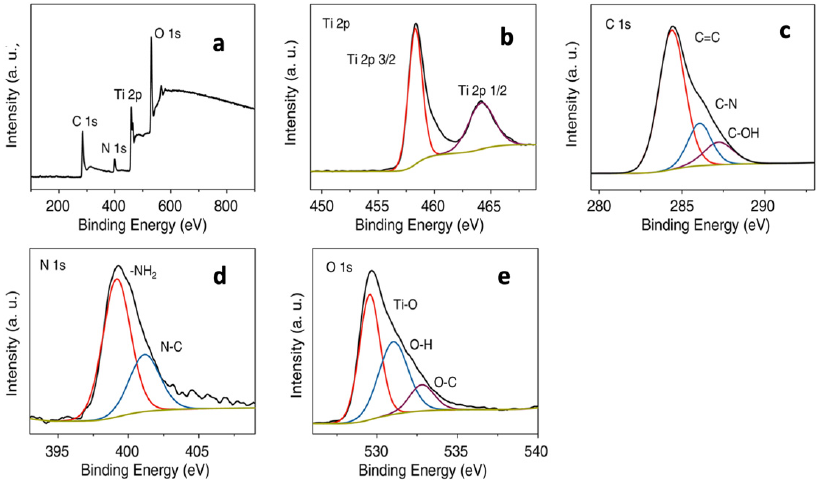
Figure 21. ( a ) XPS survey spectrum, high-resolution ( b ) Ti 2p, ( c ) C 1s, ( d ) N 1s, ( e ) O1s spectra of TiO 2 -GQD composites. Figure 21 reprinted with permission from [71]. Copyright @ 2016 American